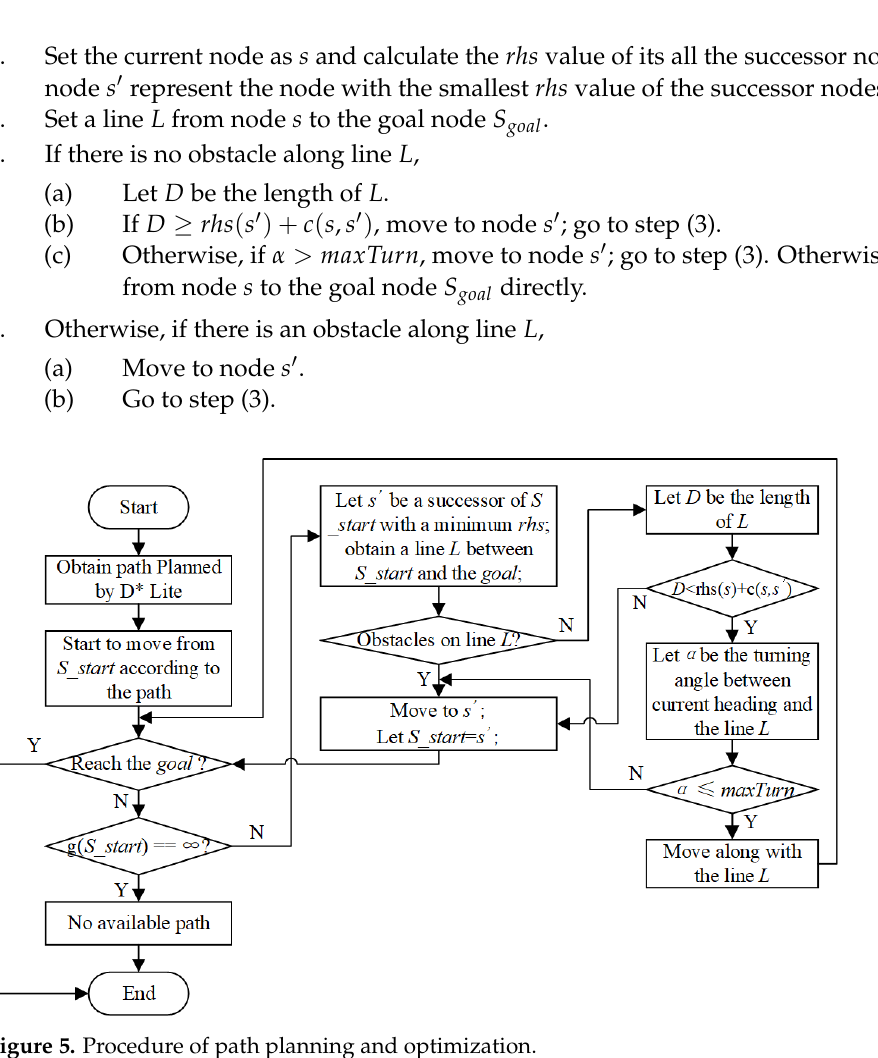
Figure 5. Procedure of path planning and